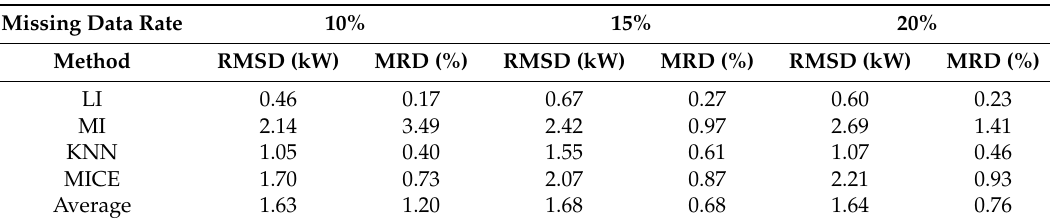
Table 2. Deviation of missing data imputation from the PV forecasting model in January using the test set. MRD, mean relative deviation;